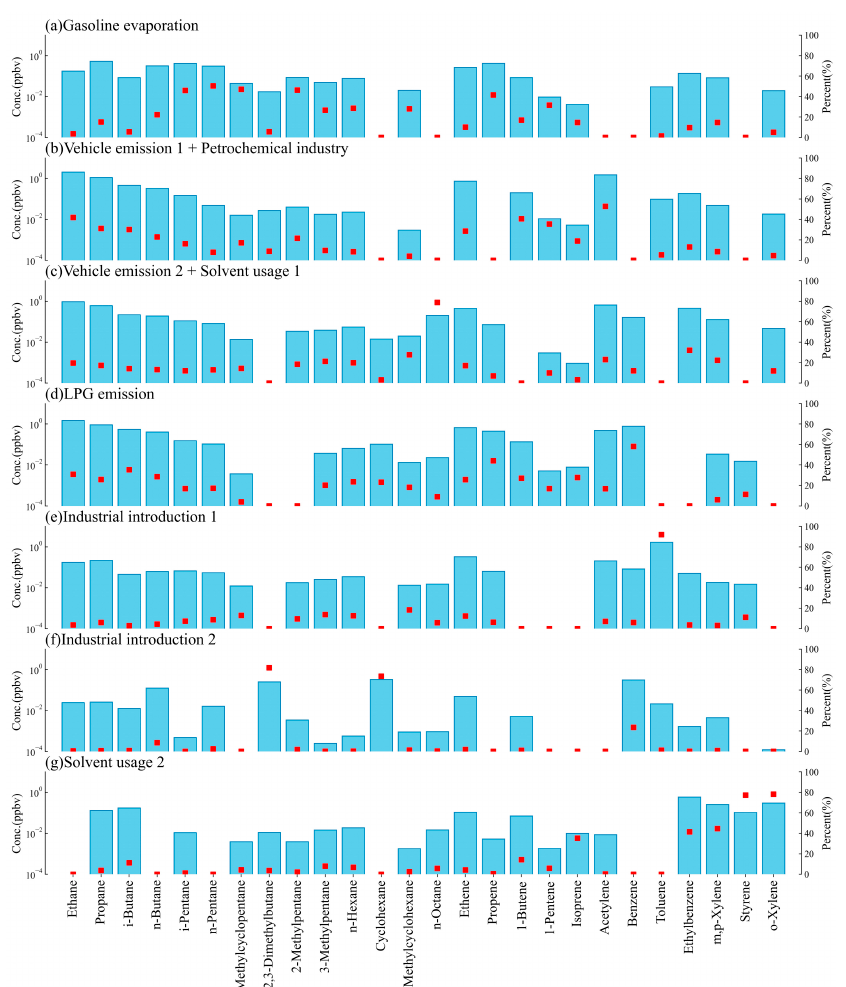
Figure 6. The source profiles (blue bars) and distributions of each species for the different factors (red squares) in the spring. ( a ) Gasoline evaporation; ( b ) Vehicle emission 1 + Petrochemical industry; ( c ) Vehicle emission 2 + Solvent usage 1; ( d ) LPG emission; ( e ) Industrial introduction 1; ( f ) Industrial introduction 2; ( g ) Solvent usage